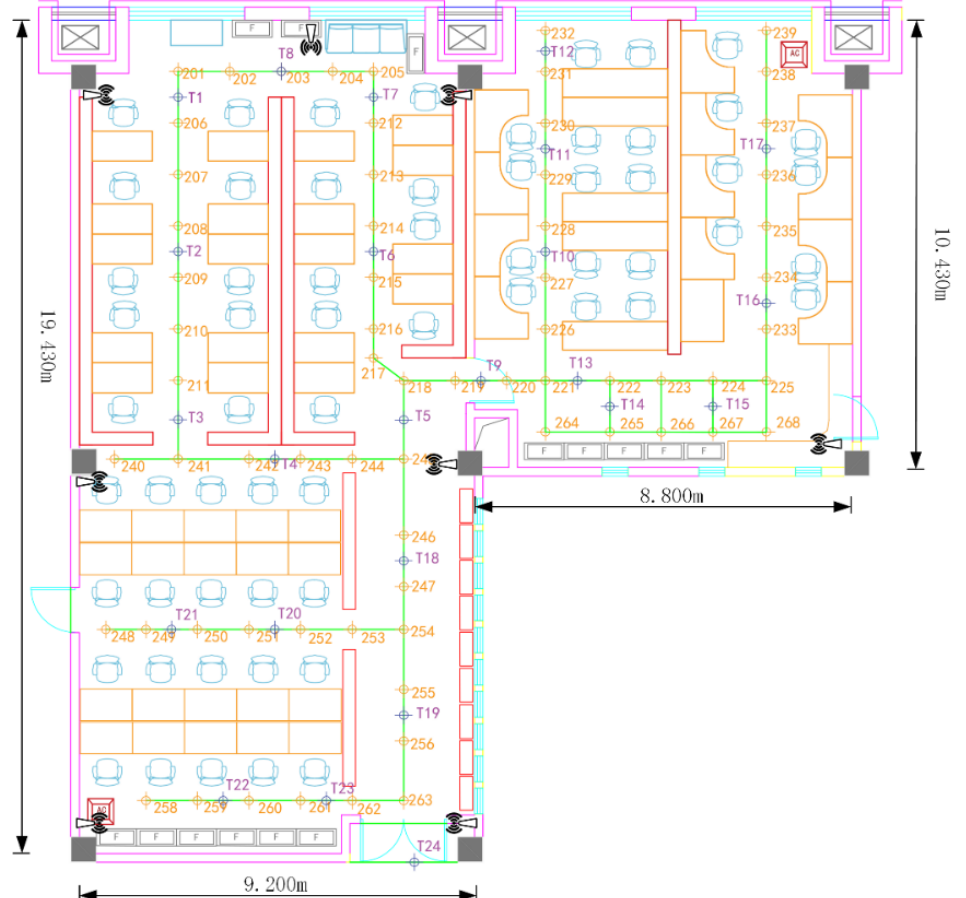
Figure 4. Scenario A. The wooden desk is in orange, the wooden cabinet is in red, the plastic chair is in blue. Wireless signal station denotes access point, reference points, and test points are illus- trated in different